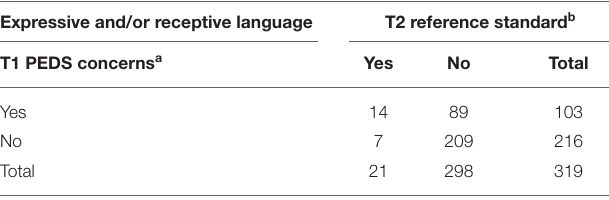
TABLE 4 | The predictive validity of PEDS concerns about language development at the age of 3 years. Expressive and/or receptive language